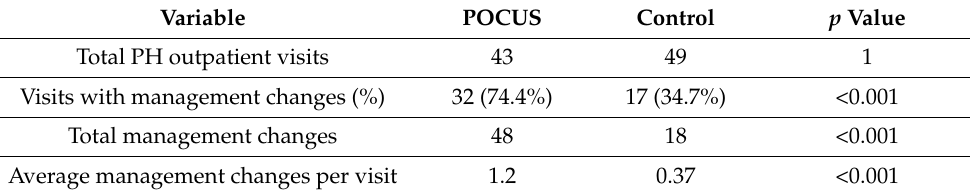
Table 2. Total management